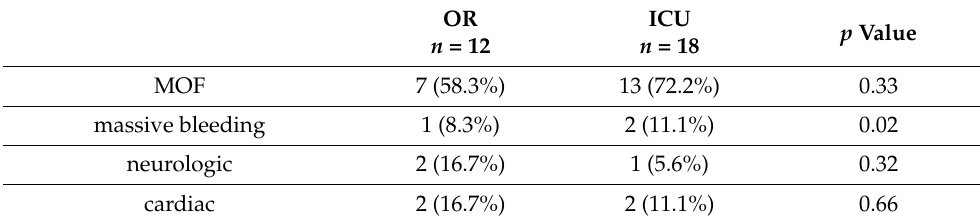
Table 5. Cause of death.